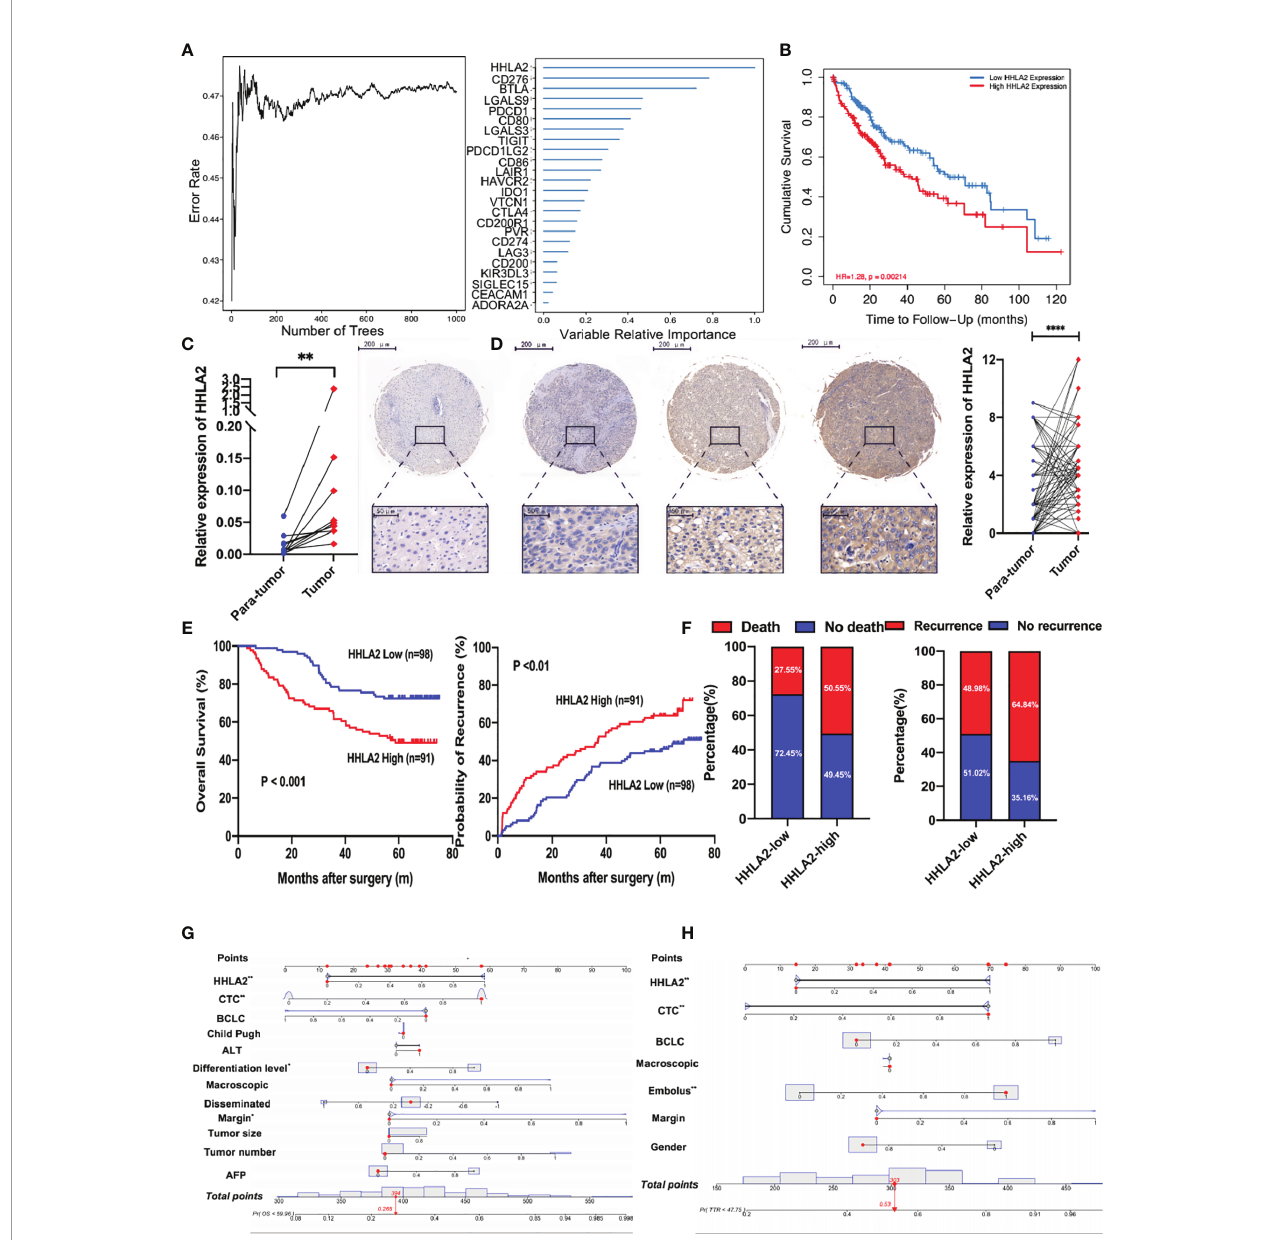
FIGURE 1 | The prognostic value of HHLA2 in TCGA and Zhongshan cohorts. (A) RandomForest results of the relative importance of 25 ICPs. (B) Kaplan – Meier plot of HHLA2 expression by TIMER2. (C) qPCR validation of HHLA2 expression in para-tumoral and tumoral tissues. (D) IHC results of relative expression of HHLA2 in paired tissues. (E) Kaplan – Meier analyses of HHLA2 for overall survival (left) and time-to-recurrence (right) in Zhongshan cohort. (F) Fraction of death and recurrence in HHLA2- high and HHLA2-low subgroups. (G) Nomogram of HHLA2 and other clinical features for overall survival. (H) Nomogram of HHLA2 and other clinical features for time-to- recurrence. *p < 0.05, **p < 0.01, ****p <